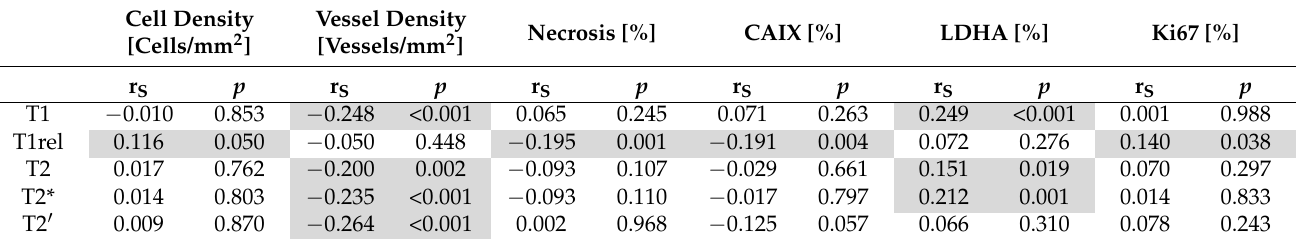
Table 3. Correlations of qMRI parameters and neuropathological features. Significant correlations are highlighted in grey. CAIX, carbonic anhydrase IX, LDHA, lactate dehydrogenase A, r S = Spearman correlation coefficient, p = p -value. For glioblastoma samples only, see Supplementary Table S2.